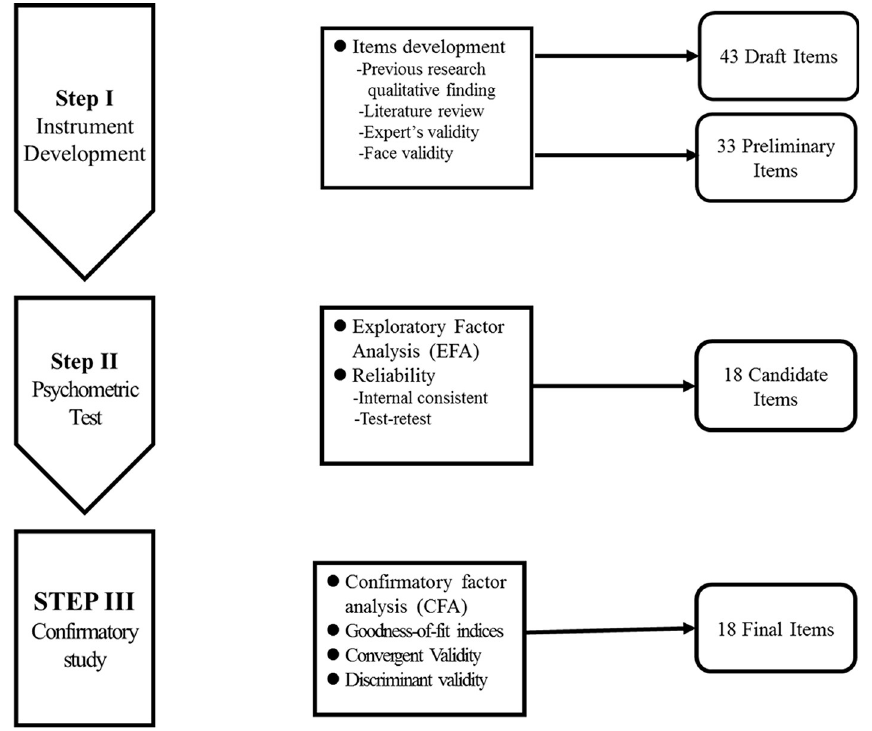
Fig 1. Steps for development and validation of